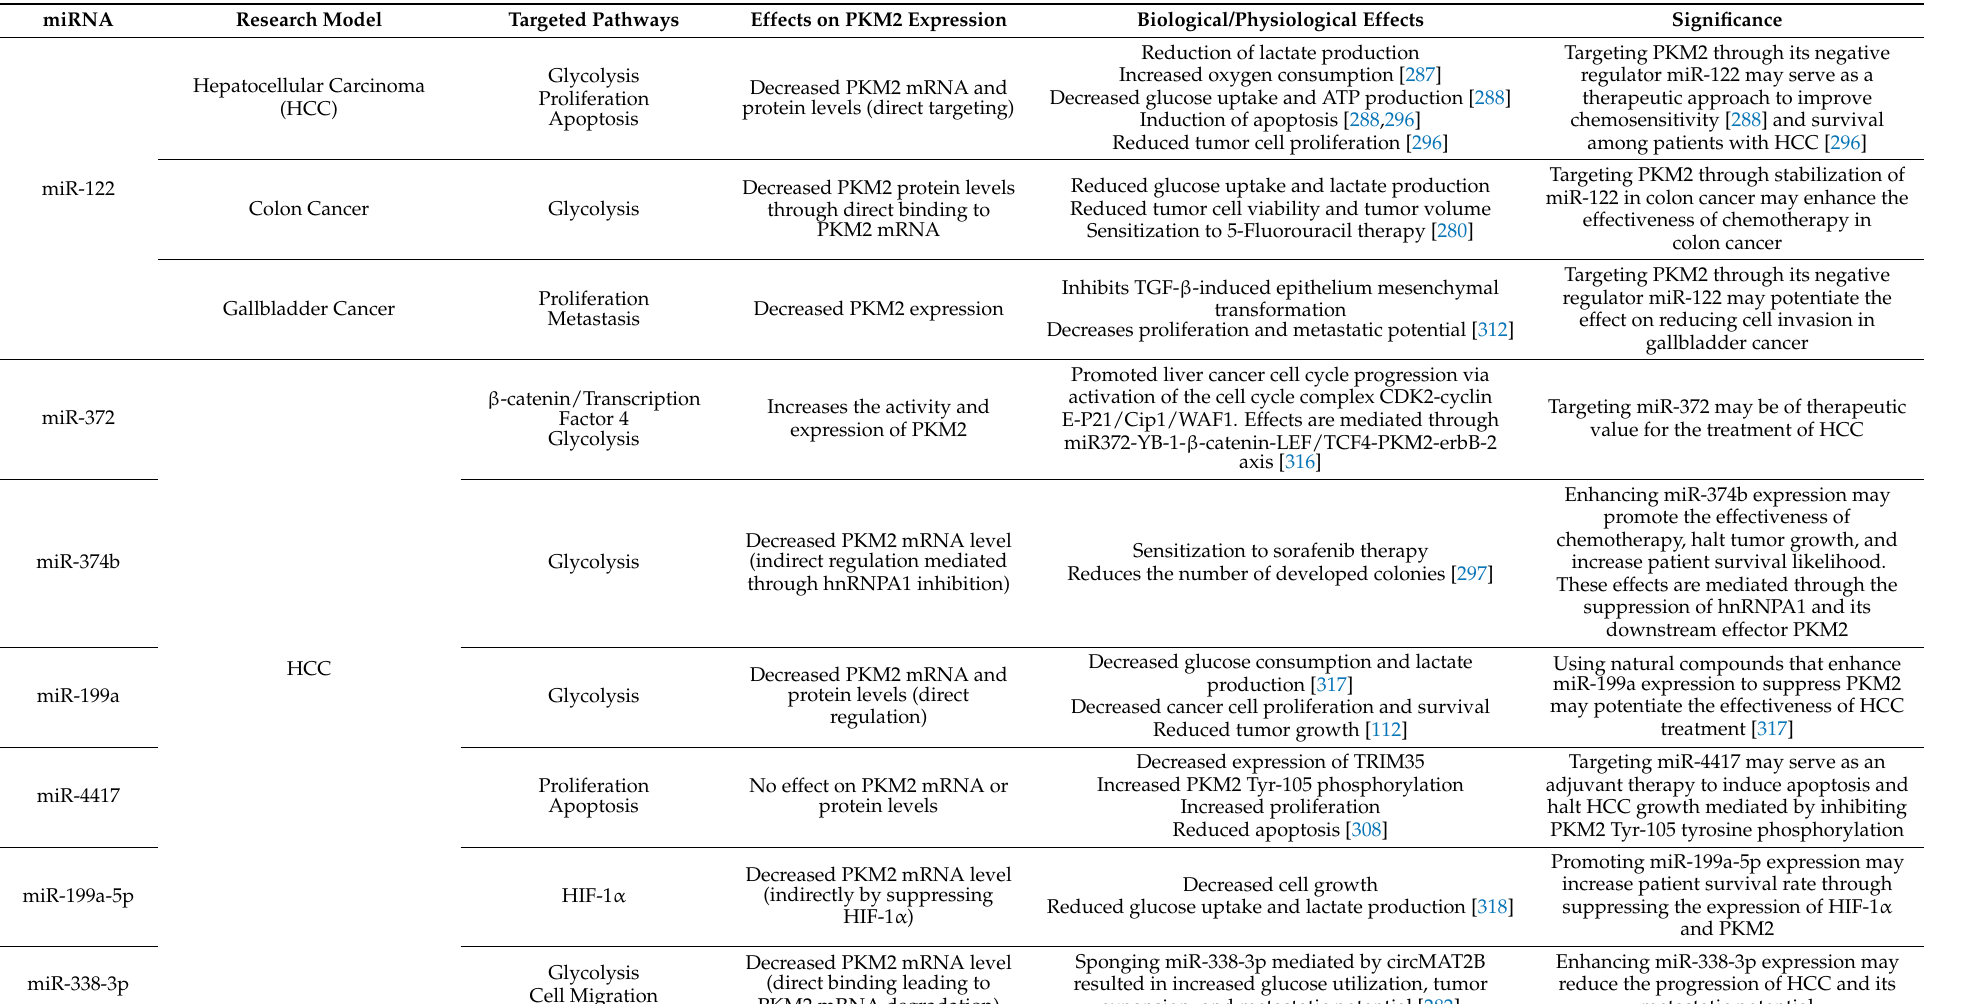
Table 1. Roles of some PKM2-associated microRNAs in